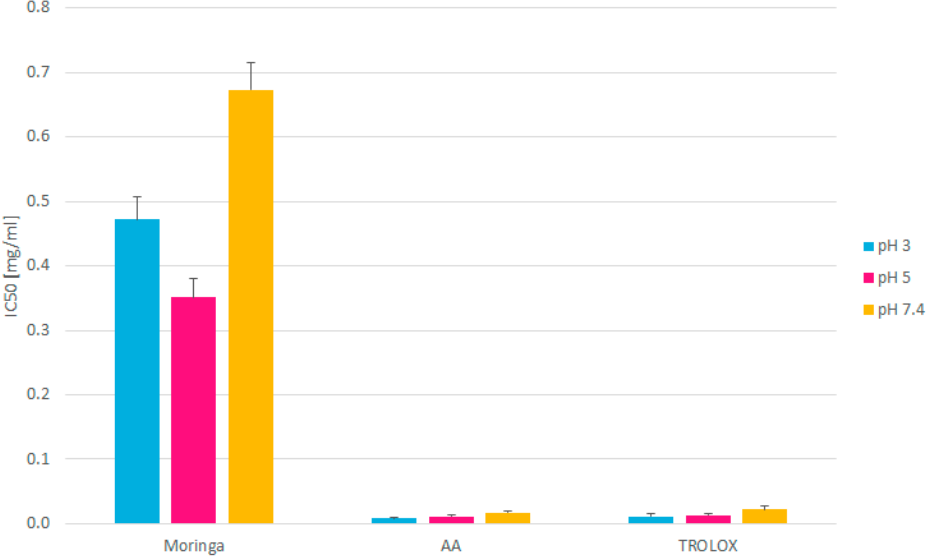
Figure 2. IC 50 values of Moringa extracts, ascorbic acid (AA), and TROLOX at various pH values.